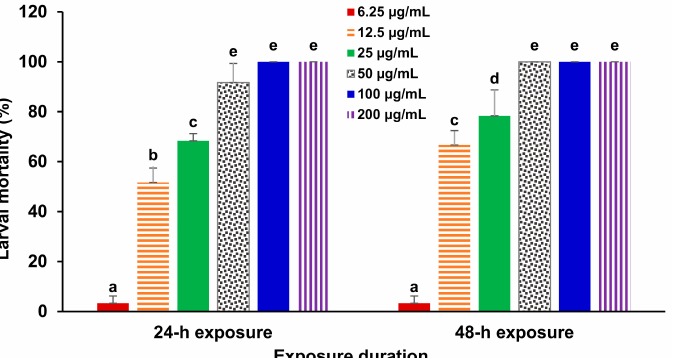
Figure 1. Percentages of mortality of third instar Ae. albopictus larvae treated with various concen- trations of the hexane extract of O. basilicum leaves for 24 and 48 h exposure. The percentages are expressed as mean ± standard deviation of three replicates. Mean values which are statistically not significant ( p > 0.05) using one-way ANOVA are indicated with the same superscript above the